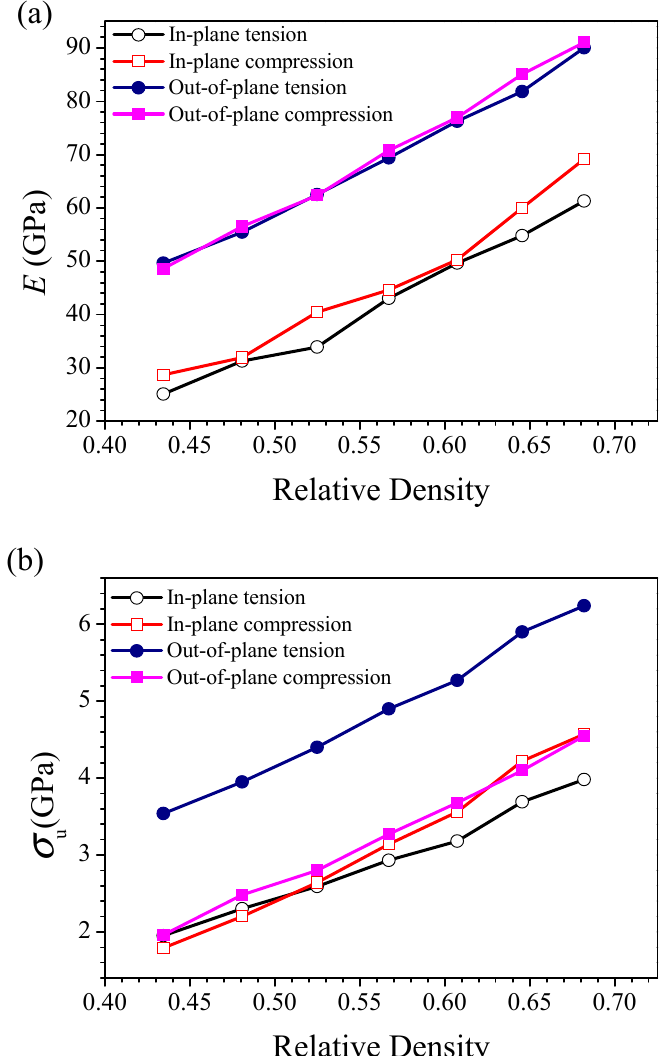
Figure 4. ( a ) Young’s modulus E and ( b ) ultimate strength σ u of HONNs with different relative